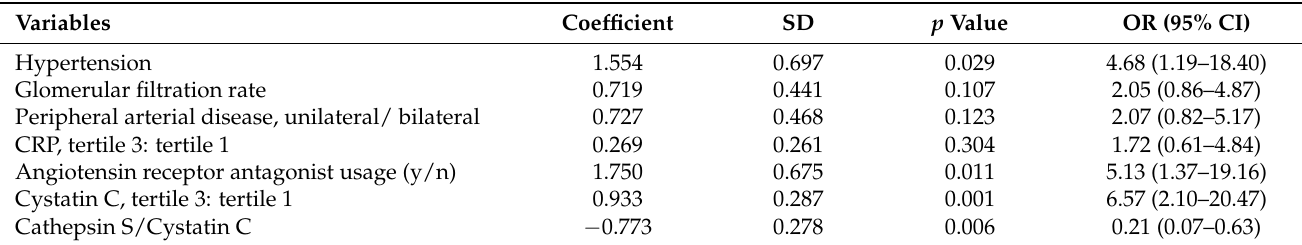
Table 4. Univariate logistic regression of variables associated with low ABI ( ≤